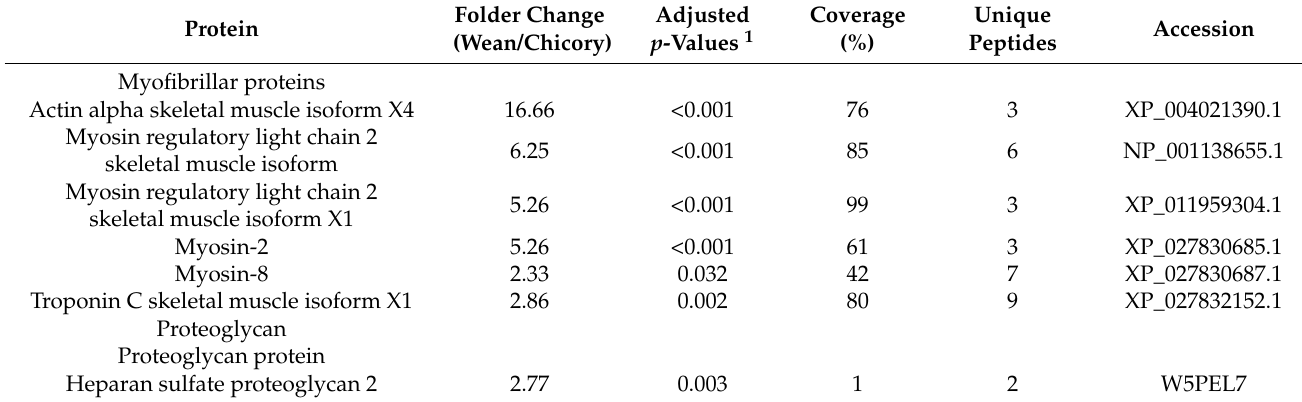
Table 5. Identified myofibrillar and proteoglycan proteins that significantly differed ( p < 0.05) between raw lamb longissimus lumborum muscle from 4-month-old pre-weaning lambs and 6- to 8-month-old wether lambs grazed on chicory. n = 7 for WEAN-W and n = 6 for